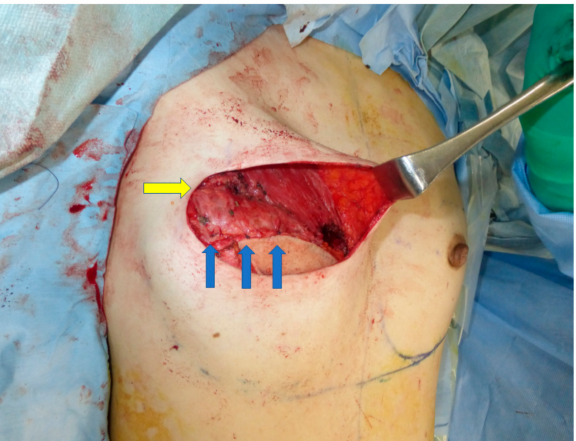
Figure 2. The caudal edge of the muscle roll (yellow arrow) is sutured to the cephalad edge of the PAP flap to reconstruct a smooth plane (blue arrows).